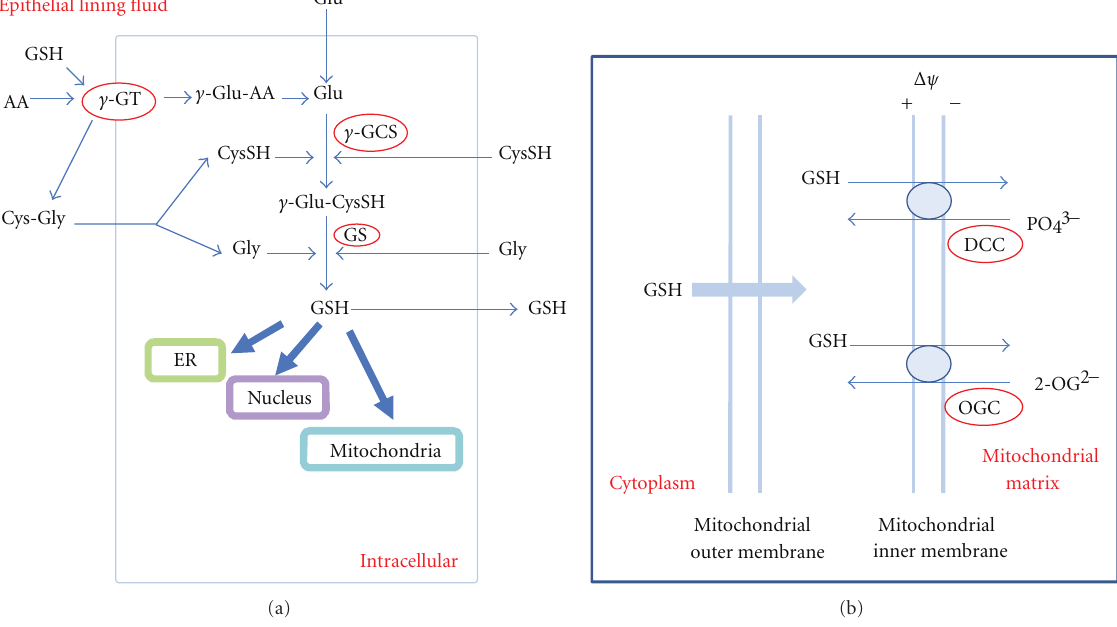
Figure 3: Glutathione synthesis, transportation, and compartmentalization. (a) GSH de novo synthesis requires glutamate (Glu), cysteine (Cys), and glycine (Gly). Key enzymes involved are g-GT: g-glutamyltransferase; g-GCS: γ -glutamylcysteinesynthetase; GS: glutathionsyn- thetase. GSH is freely distributed in the cytosol, but also compartmentalized in mitochondria, nucleus and ER. (b) GSH transports from cytosol to mitochondrion. GSH can move easily through the mitochondrial outer membrane, but requires carrier-mediated transport to cross the mitochondrial inner membrane. DCC: dicarboxylate carrier; OGC: 2-oxoglutarate carrier.